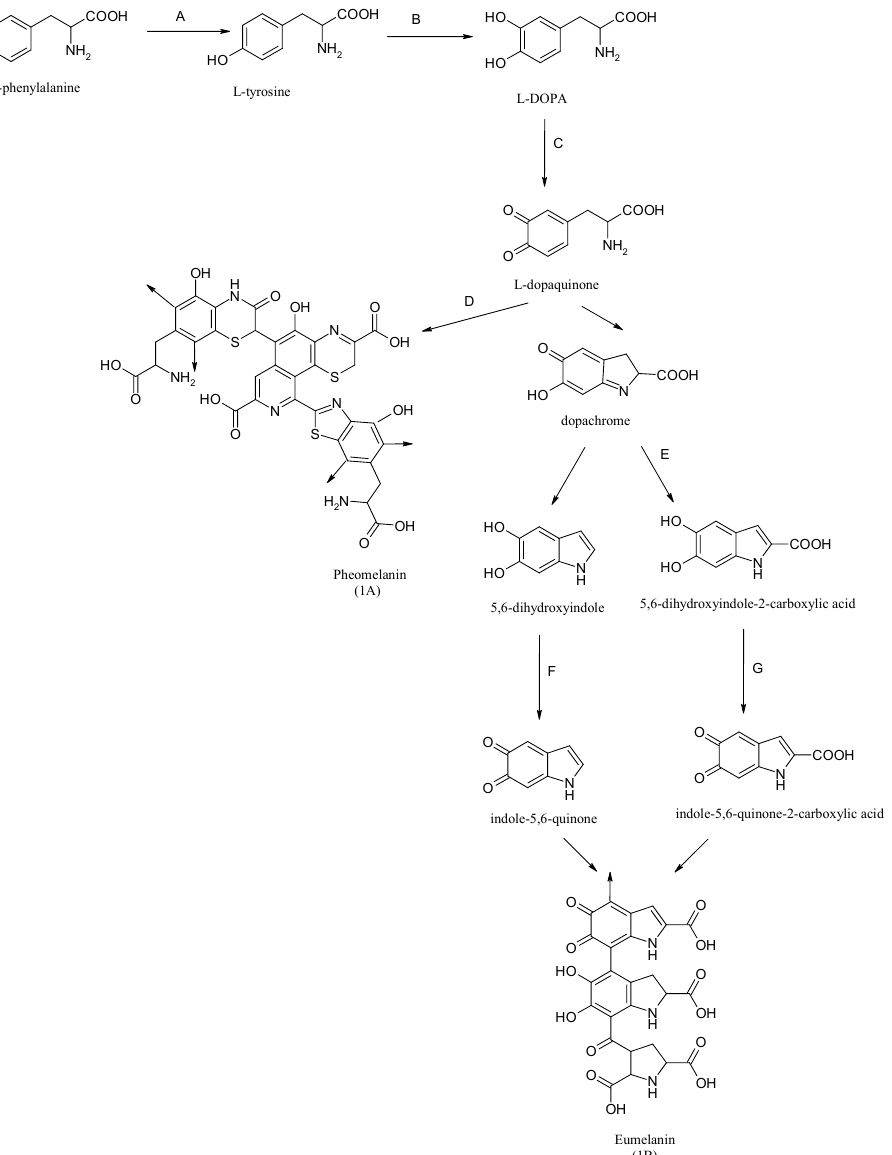
Figure 1. Process of melanogenesis in human epidermal melanocytes. Symbols: A-phenylalanine hydroxylase, B,C,F tyrosinase, D-glutathione or cysteine, E-tyrosinase related protein-2, G-tyrosinase related protein-1. Arrows in (1A) and (1B) mean position of further polymerization of parent molecule.